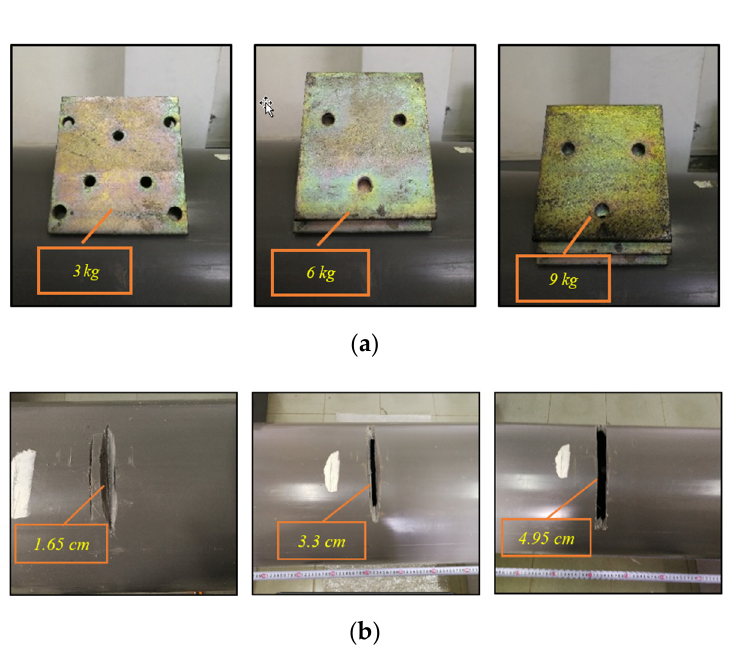
Figure 15. Damage conditions setting: ( a ) additional mass conditions and ( b ) stiffness damage con- ditions. Table 4. Setting of experimental conditions.